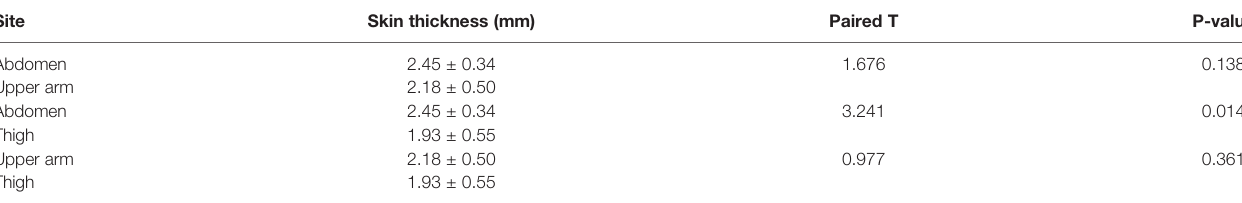
TABLE 2 | Difference in skin thickness of the injection site.